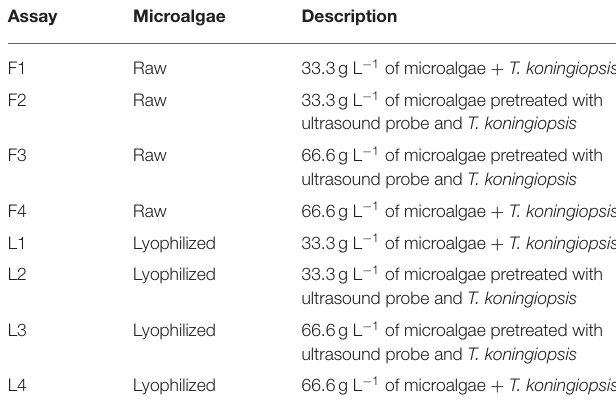
TABLE 1 | Description of the preliminary